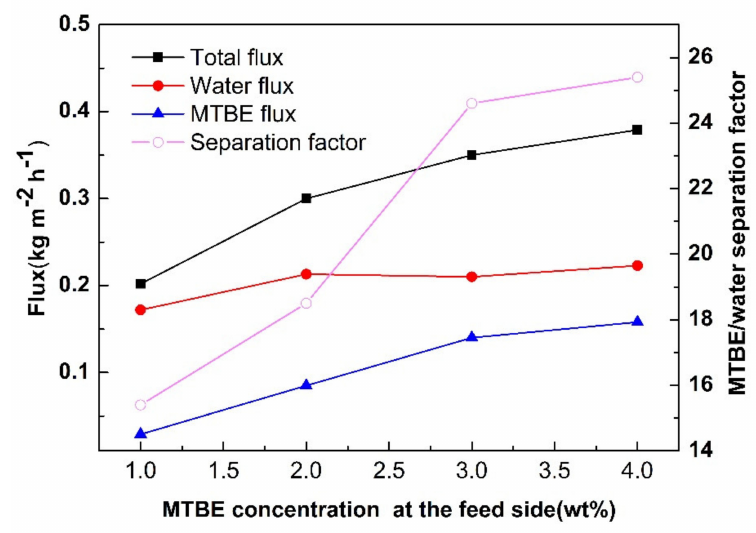
Figure 12. The MTBE / water separation performance varying with MTBE concentration at the feed